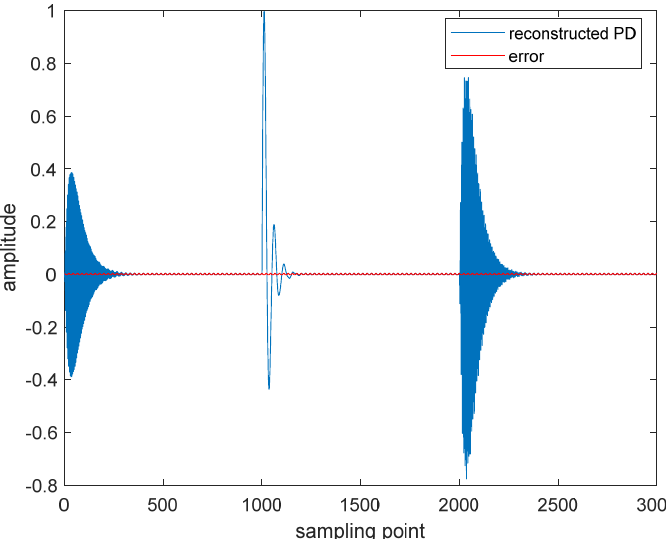
Figure 8. Reconstructed PD signal and the error.